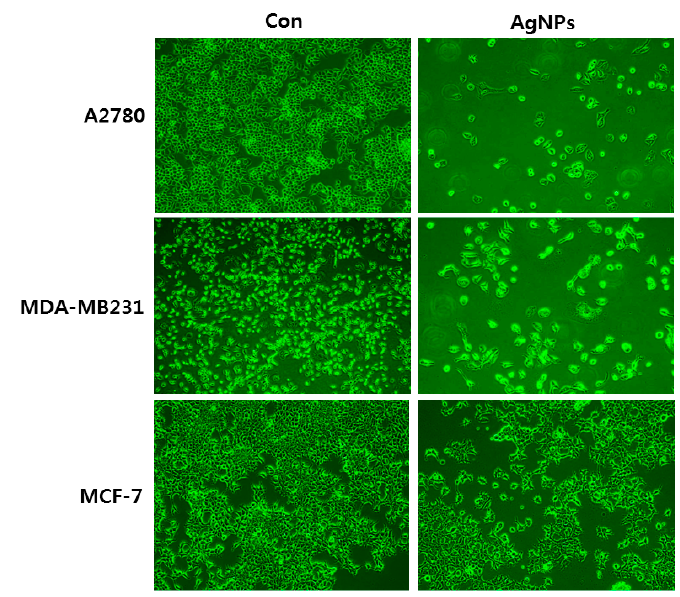
Figure 2. Effect of silver nanoparticles on cell morphology of human ovarian cancer cells (A2780), human breast cancer cells MDA-MB231, and MCF-7. The images were taken from the cells were treated with an average size of 40 nm for 24 h.